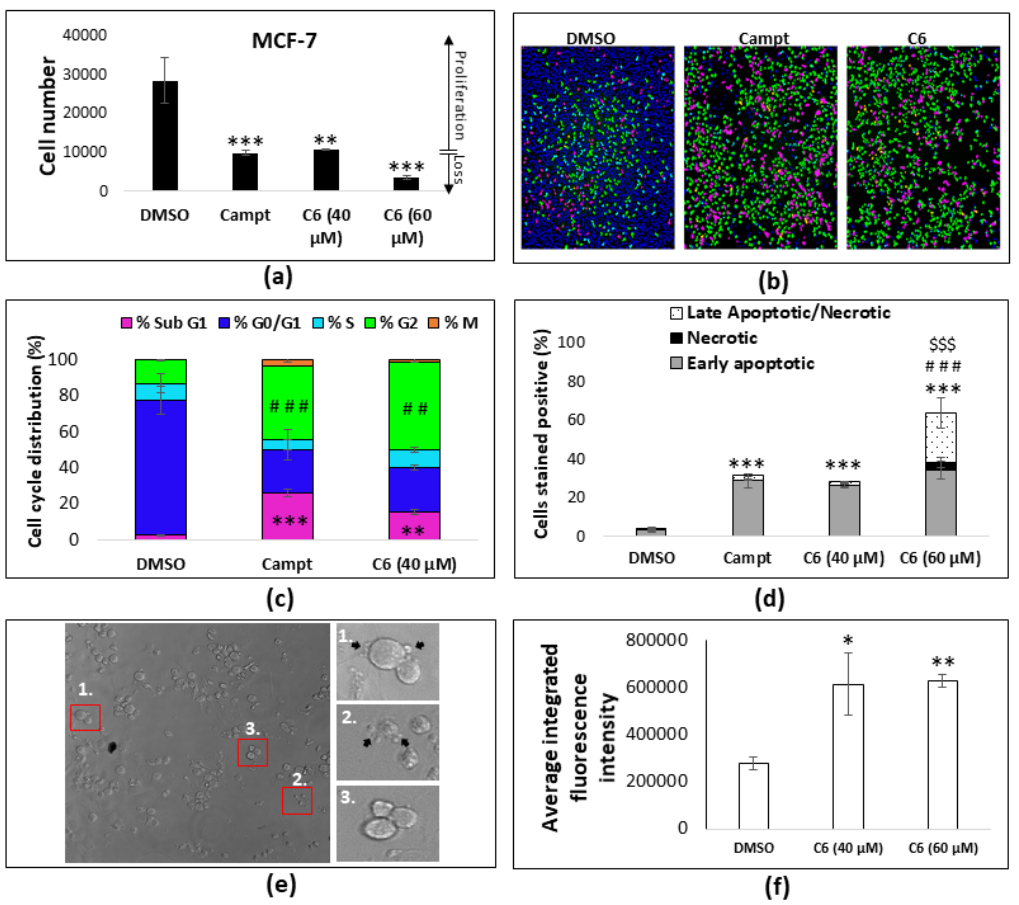
Figure 7. Mechanism of action through which C6 induces its anti-proliferative action. ( a ) Cell number determination in the MCF-7 cell after treatment at two concentrations, using the Hoechst 33,342 staining and image acquisition method. ** p < 0.01, *** p < 0.001 relative to DMSO vehicle control. ( b ) Representative images acquired during cell cycle analysis, where each color represents the phase of the cell cycle assigned to the specific cell based on the intensity of the Hoechst 33,342 staining. ( c ) Quantitative analysis of the percentage of the cell population in each phase of the cell cycle. Camptothecin (5.74 µ M) was used as a positive control for cell cycle arrest in the G2 phase. ** p < 0.01, *** p < 0.001 relative to the DMSO vehicle control of % Sub G1; ## p < 0.01, ### p < 0.001 relative to DMSO vehicle control of %G2 using a one-way ANOVA with post hoc Tukey test ( n = 3). ( d ) Quantitative analysis of the cell population undergoing apoptosis or necrosis. *** p < 0.001 relative to the % of early apoptotic cells of DMSO vehicle control; ### p < 0.001 relative to the % of necrotic cells of DMSO vehicle control and $$$ p < 0.001 relative to the % of late apoptotic cells of the DMSO vehicle control using a one-way ANOVA with a post hoc Tukey test ( n = 3). ( e ) Morphological changes induced by C6 showing membrane blebbing (black arrows) and cell shrinkage. ( f ) Quantification of the average integrated nuclear fluorescence intensity. * p < 0.05, ** p < 0.01, relative to the DMSO vehicle control. Campt, camptothecin.